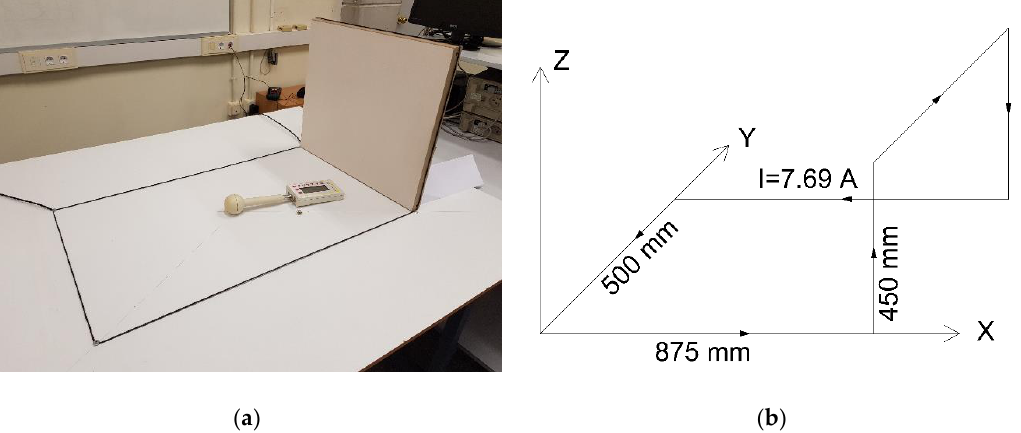
Figure 2. ( a ) Simulated and measured circuit and ( b ) its 3D Figure 2. (a) Simulated and measured circuit and (b) its 3D representation.